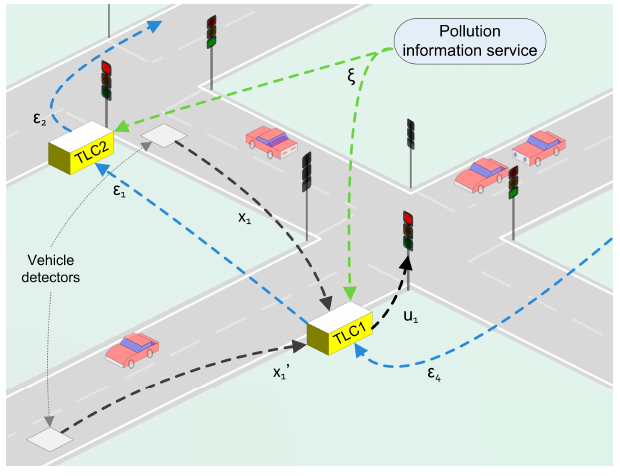
Figure 7. TLCs interaction scheme.